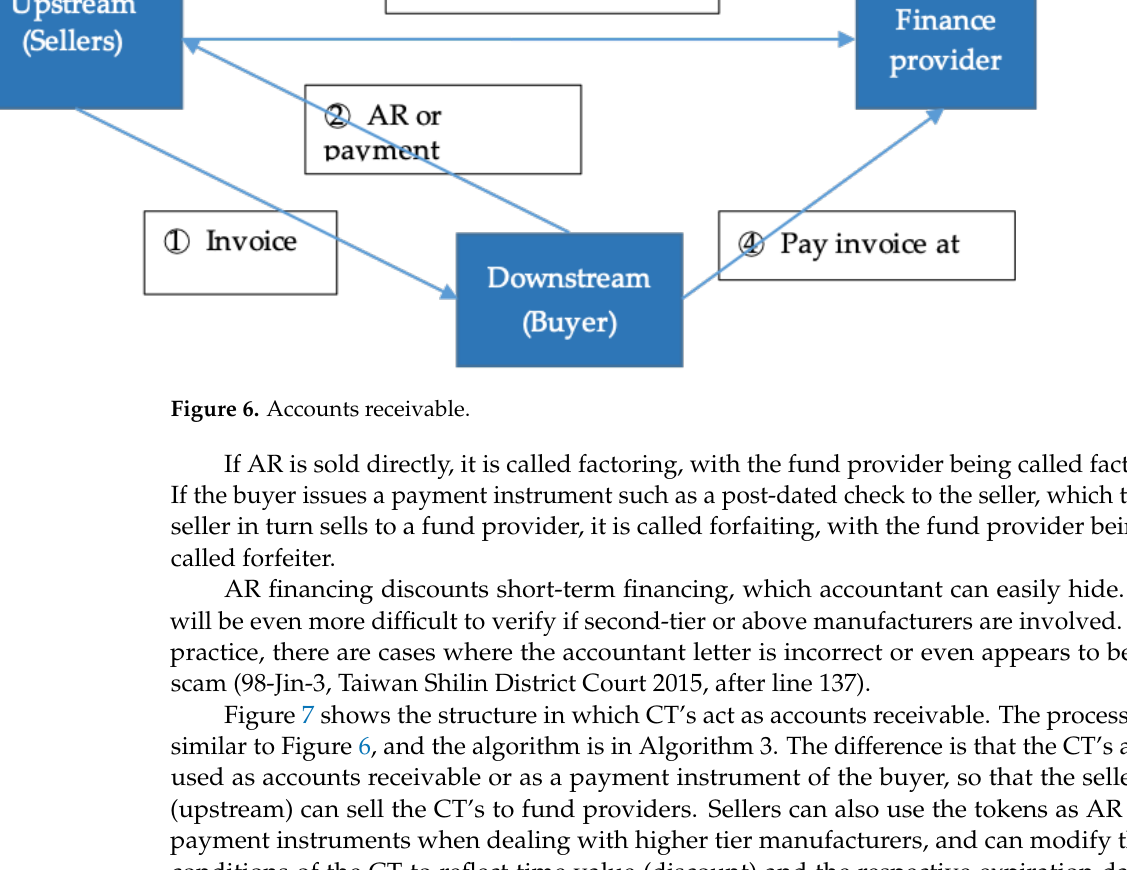
Figure 6. Accounts receivable.